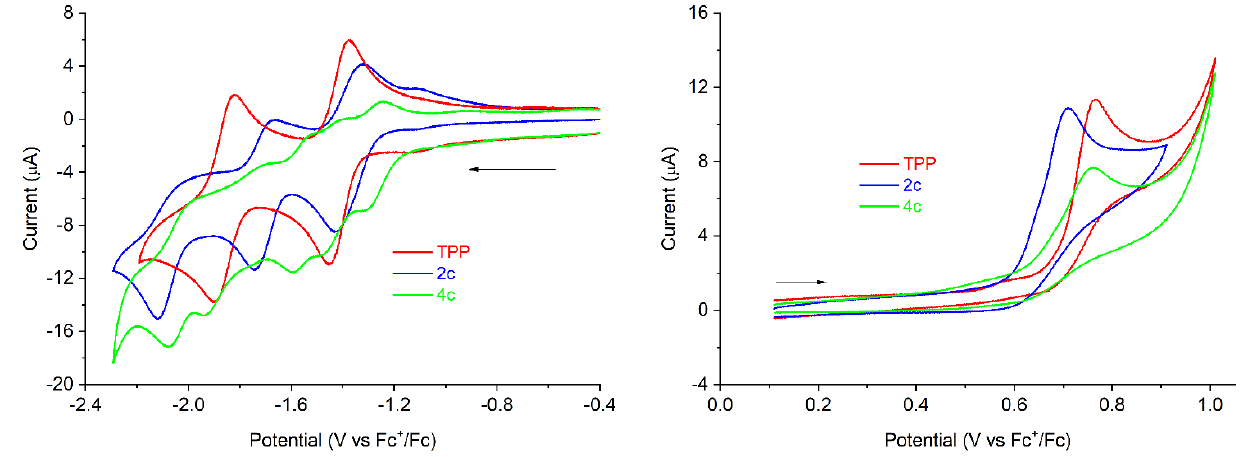
Figure 1. Cyclic voltammograms of TPP , 2c , and 4c (1 mM) in DMF with 0.1 M TBAPF 6 as a supporting electrolyte obtained at a scan rate of 100 mV s − 1 . Table 1. Summary of the electrochemical data of porphyrinic derivatives TPP , ZnTPP , 2a–c , 4a–c ,